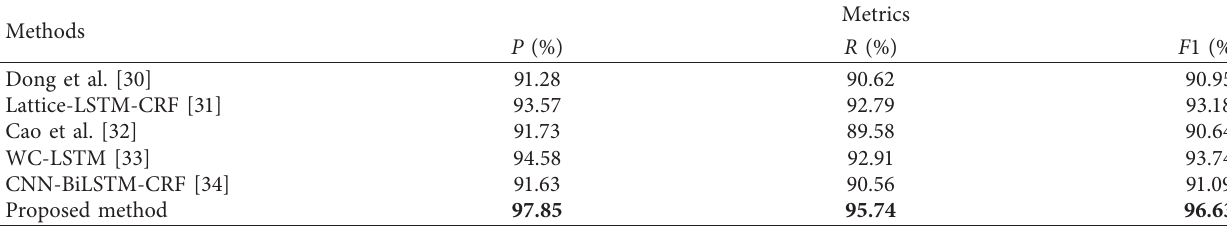
Table 3: Performance comparison of different methods on MSRA